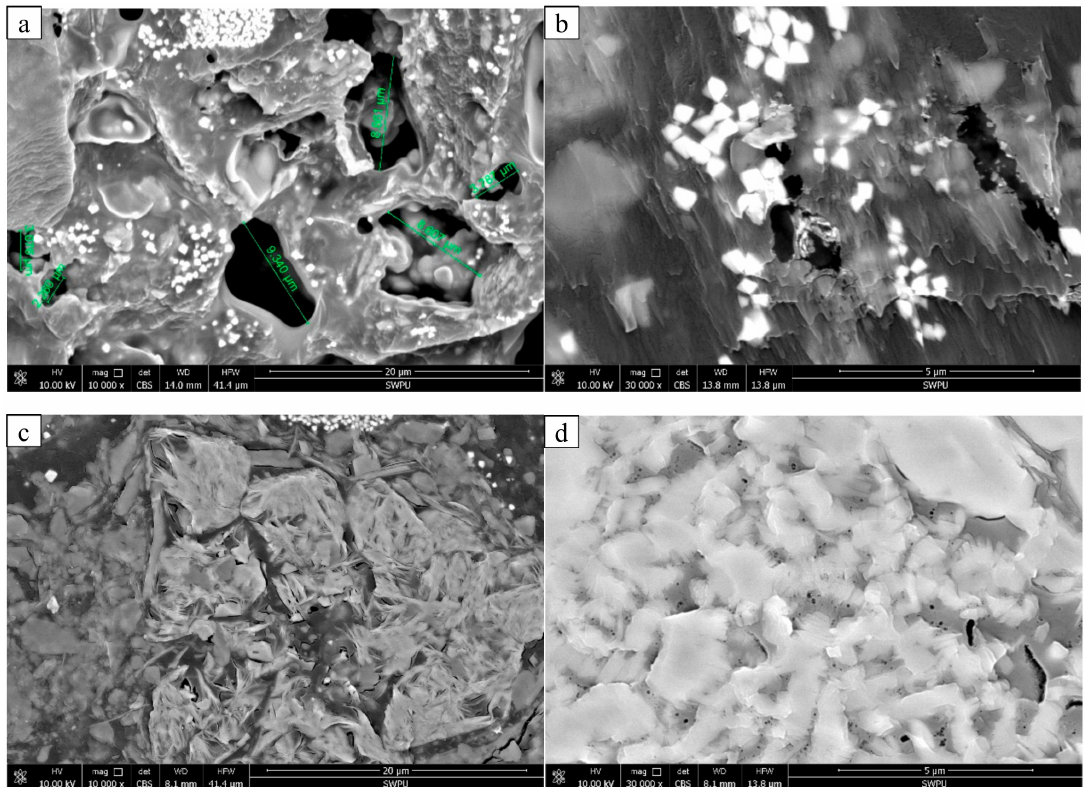
Figure 15. Porosity under scanning electron microscopy. ( a ) Intergranular dissolved pore, 2–10 µ m; ( b ) intergranular dissolved pore in quartz, 400–850 nm; ( c ) intercrystalline pore, 400–1000 nm; ( d ) organic pore, 80–250 nm.